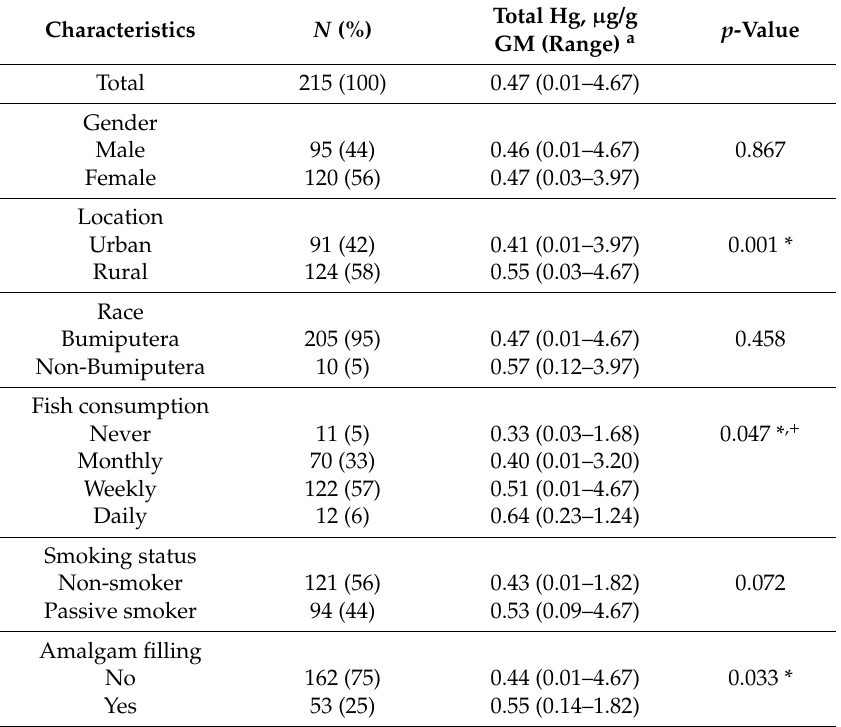
Table 1. Hair mercury levels and general characteristics of the respondents ( N = 215).